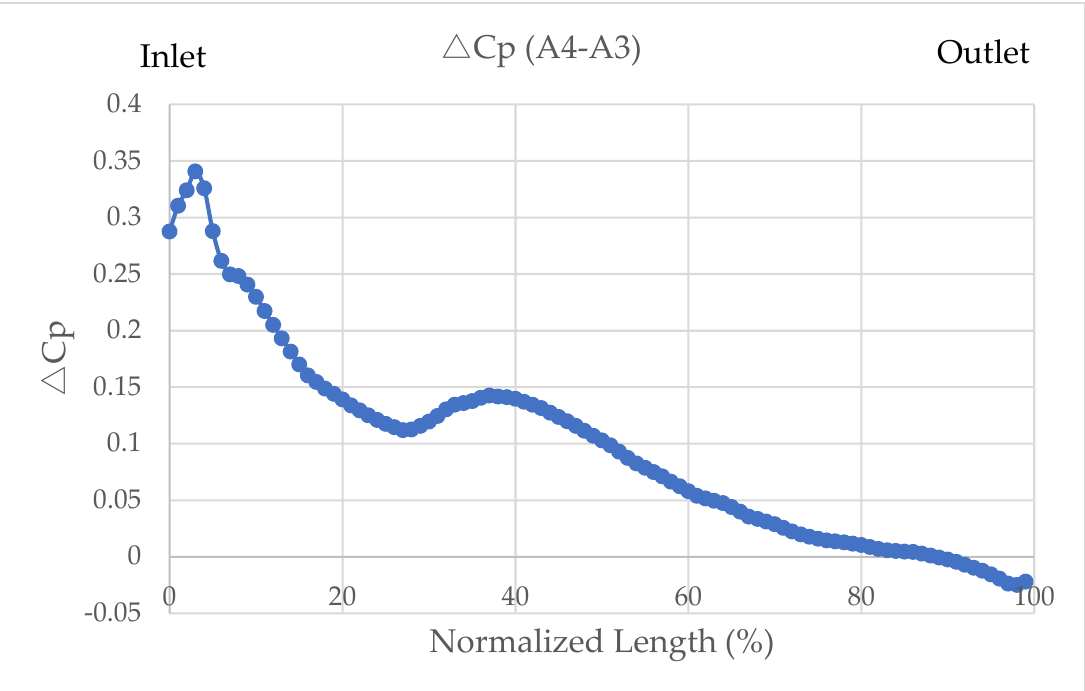
Figure 24. Difference of pressure between A4-A3. Detailed explanations of the velocity vectors and streamlines around the accommodation house are presented in Figures 25 and 26, respectively. As discussed in Figures 20 and 21, the same trends are found in Figures 25 and 26. For instance, rotating vortices are induced near the inlet and outlet of the gap. The flow velocities in the gap between the back wall of the house and the container wall are significantly greater than those in the gap between the front wall of the house and the container wall due to the flow separation and bluff-body